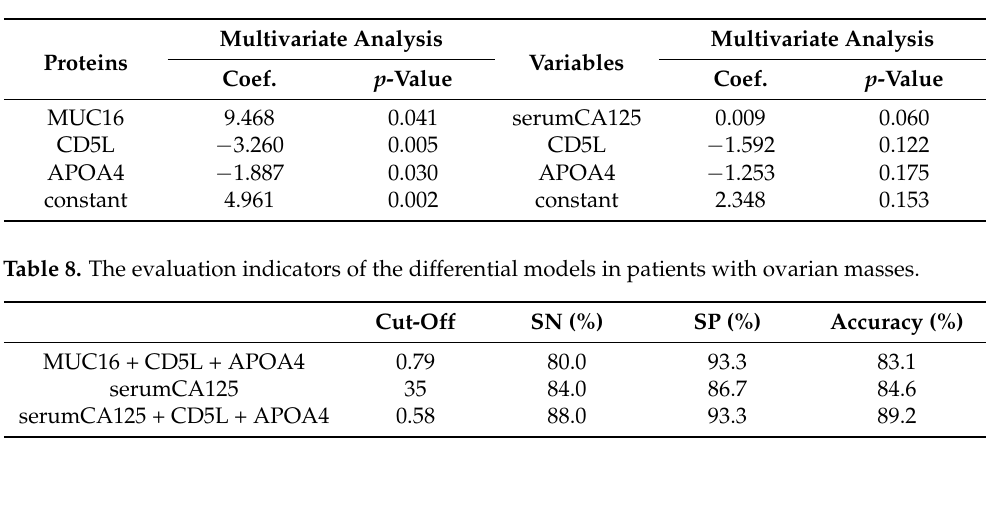
Table 7. The logistic regression model for differential diagnosis of ovarian masses.